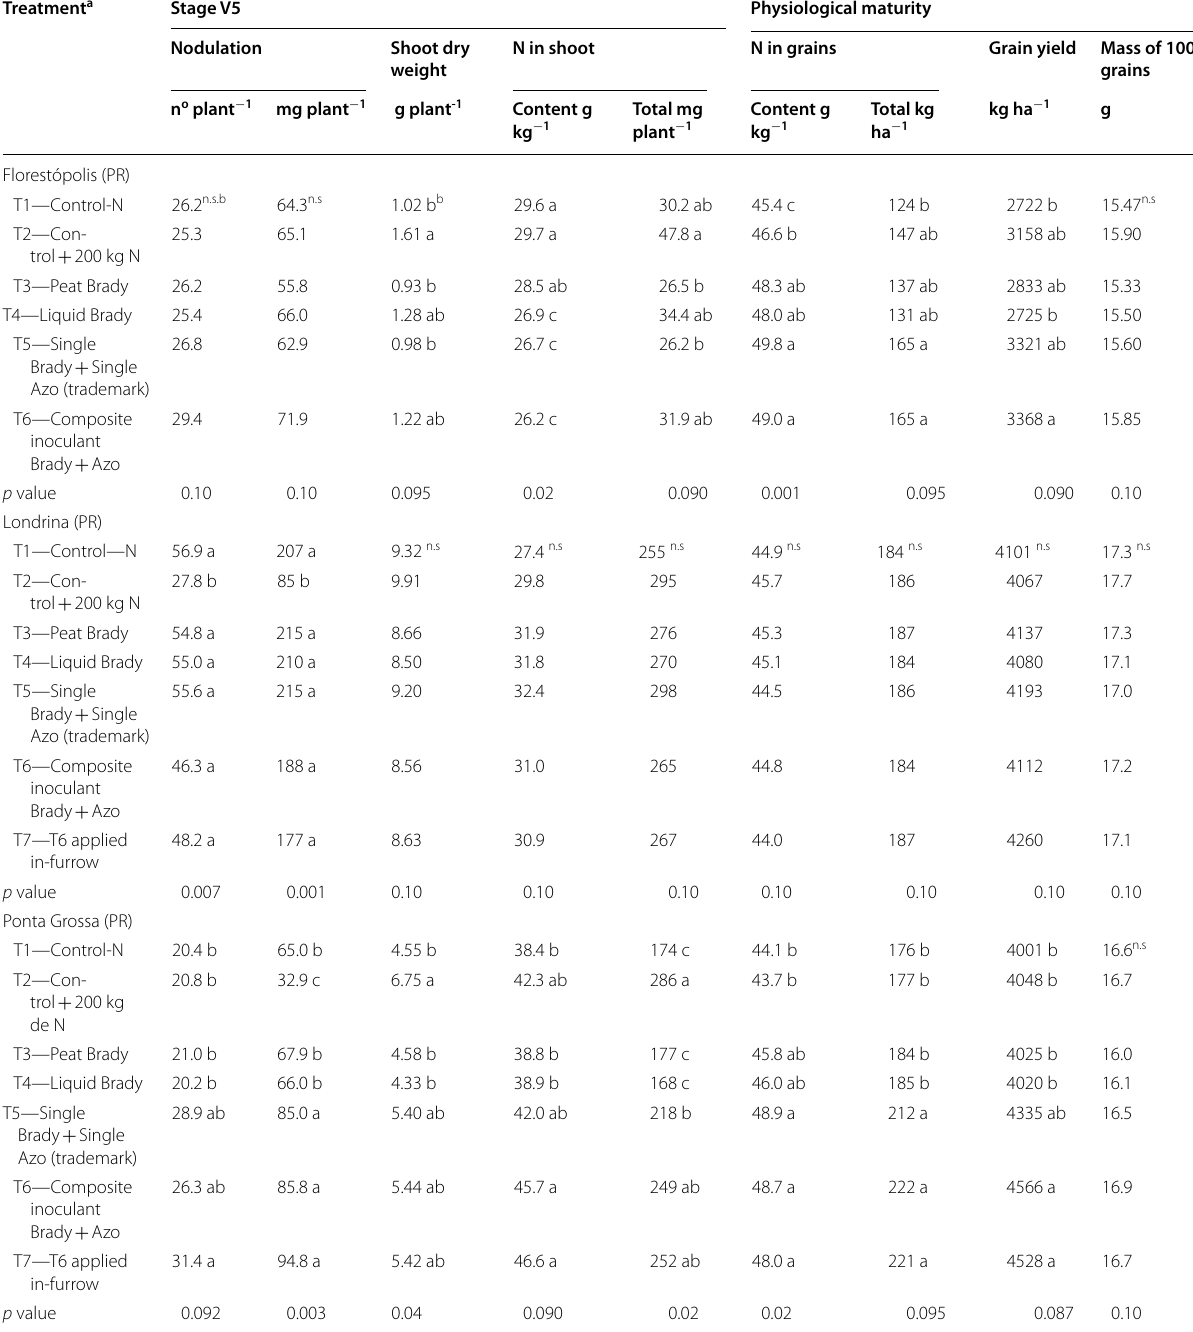
Table 6 Parameters evaluated in soybean cultivar BRS 1010IPRO with different treatments of inoculation with Bradyrhizobium and co-inoculation with Bradyrhizobium and Azospirillum in field trials performed in areas traditionally cropped with soybean, showing naturalized population of soybean bradyrhizobia, in Florestópolis-PR, Londrina-PR and Ponta-Grossa-PR,